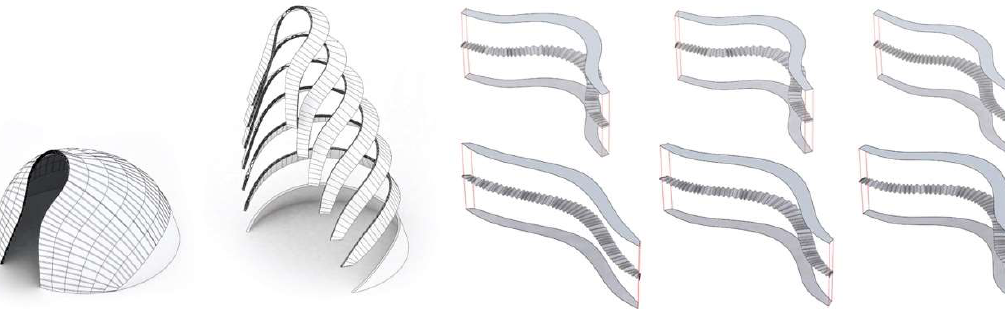
Figure 15. Form-finding of the shell using FE-simulations to ascertain the bent geometry and stresses.